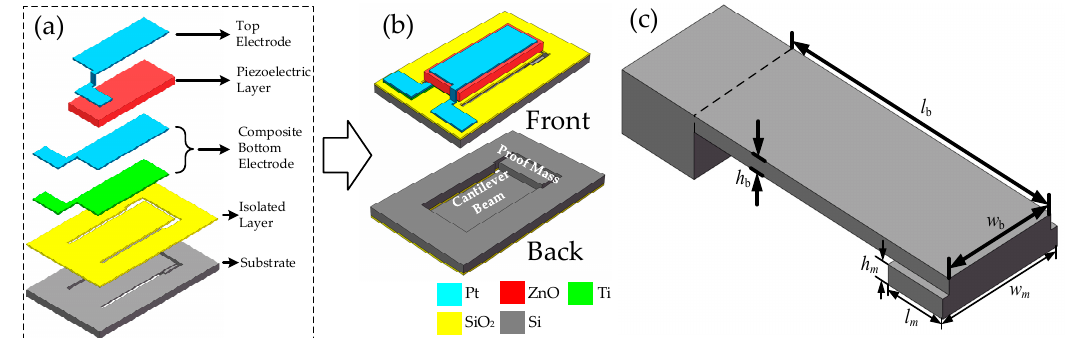
Figure 2. Basic structure of piezoelectric beam: ( a ) explosion view; ( b ) front and back side, ( c ) dimension of the cantilever beam.